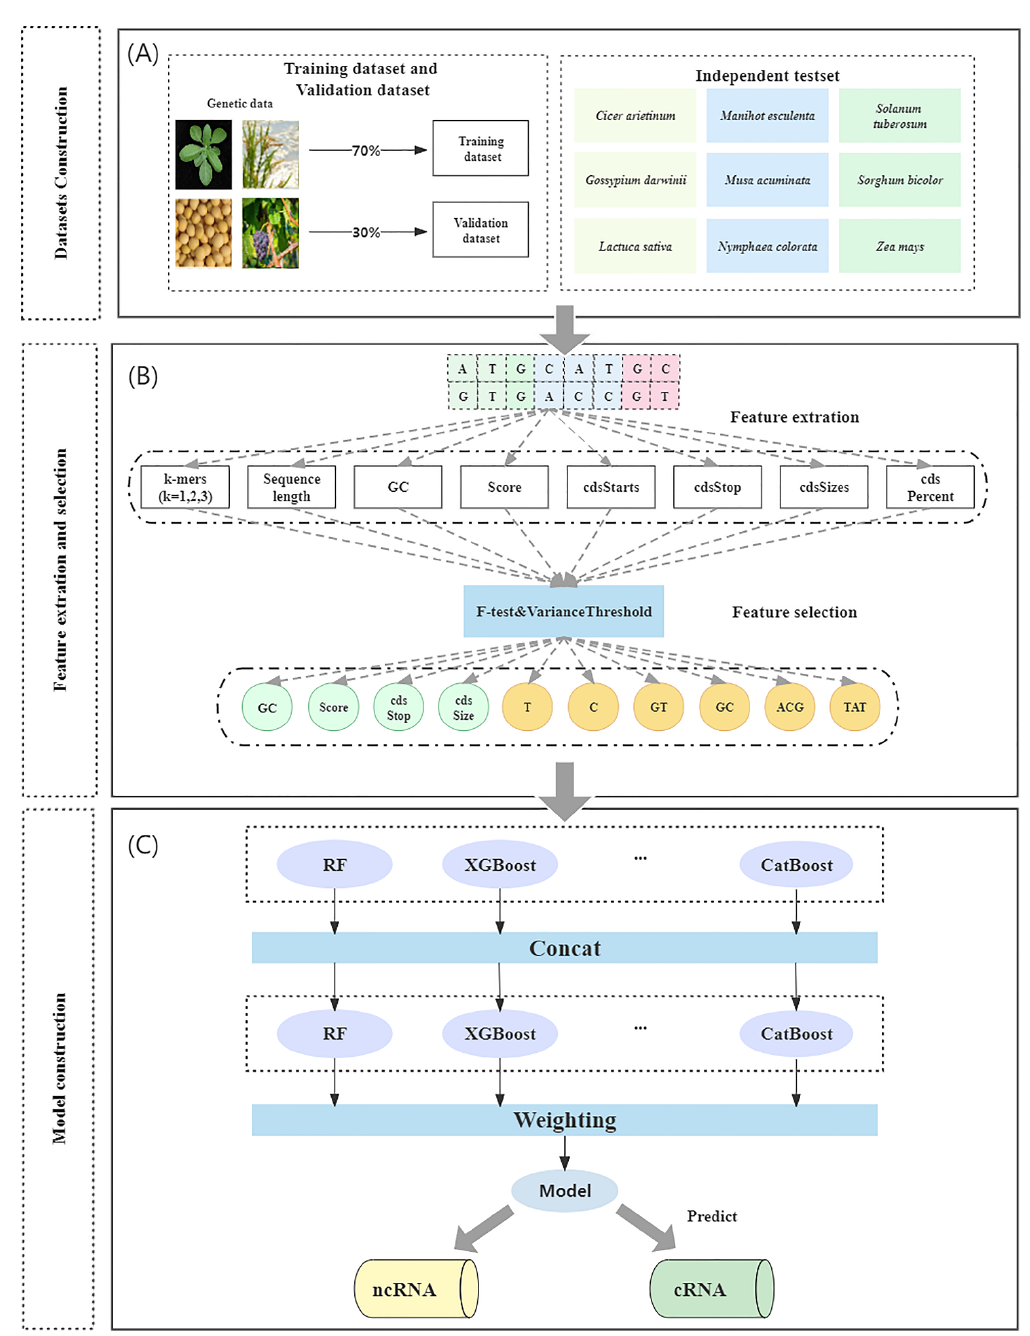
Figure 7. Overall workflow: ( A ) dataset construction: a dataset was constructed using four species of plants together for training and validation, and nine independent test sets were constructed for testing; ( B ) feature extraction: features were extracted from the original sequence species and redundant features were filtered out using feature selection methods; ( C ) model construction: a stacking strategy was used to integrate multiple